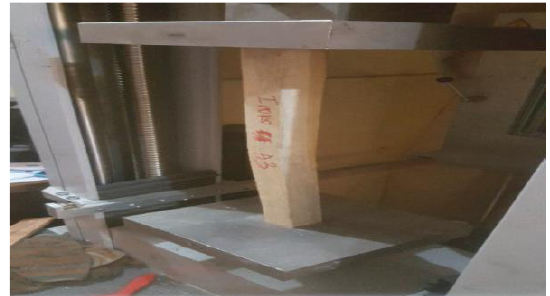
Fig. 4. The failure mode of Iroko